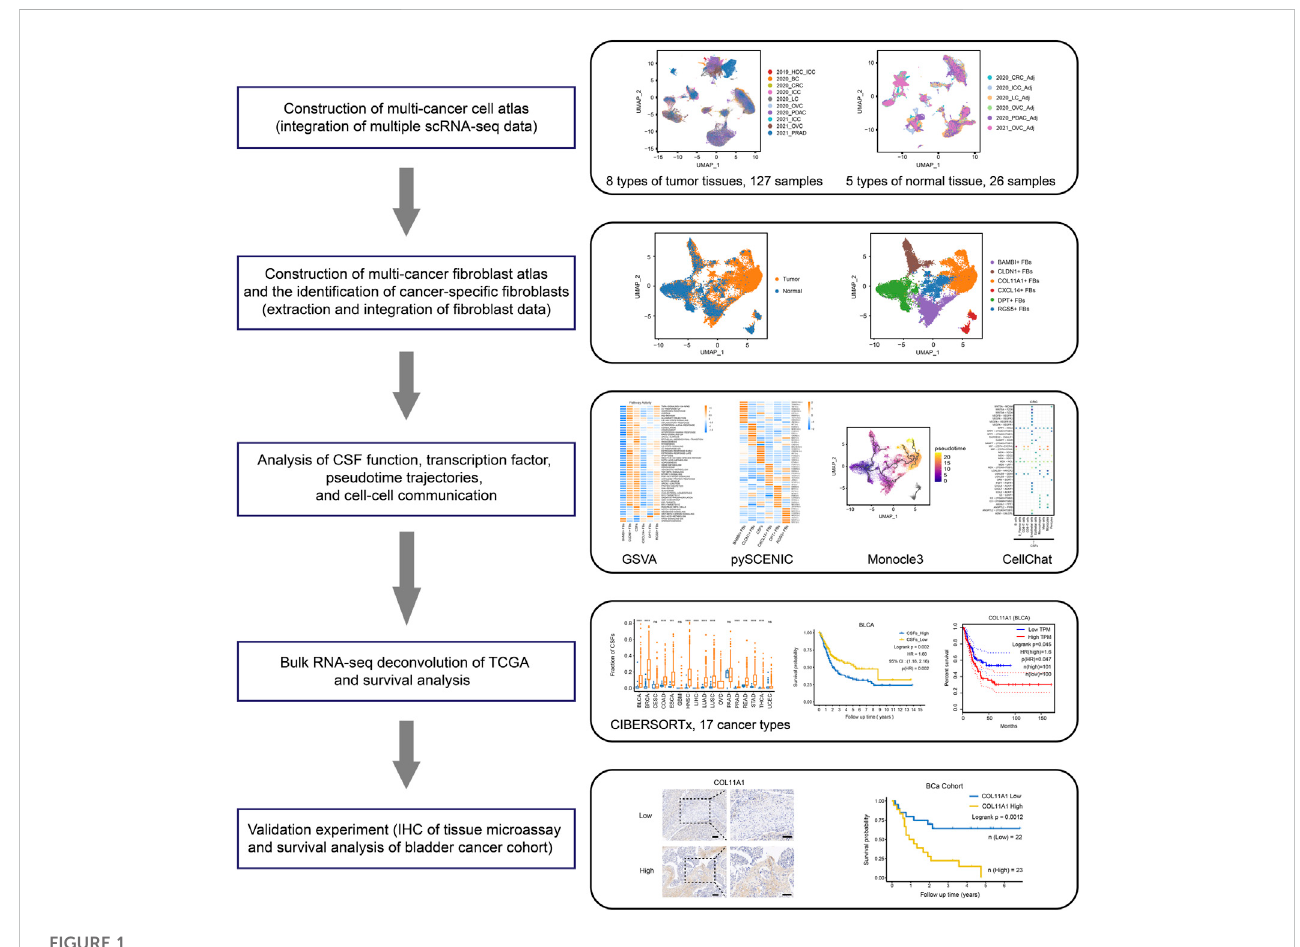
FIGURE 1 Work fl ow of this